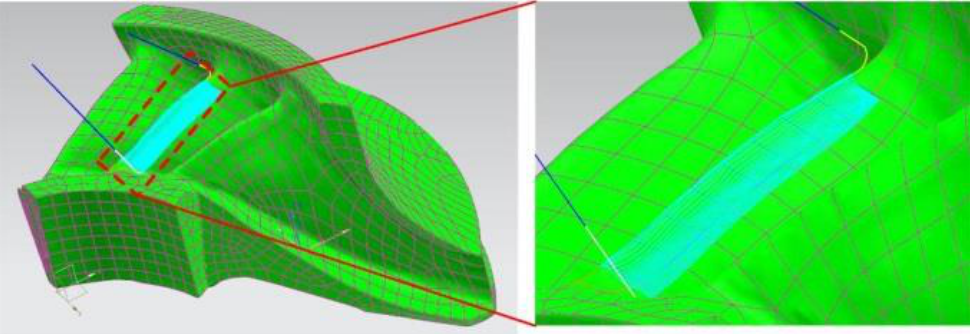
Figure 14. Multi-axis machining tool path.